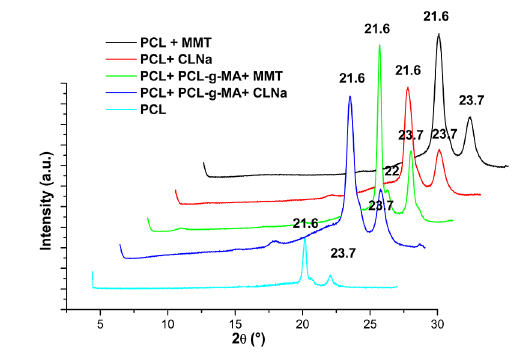
Figure 3. X-ray diffractograms of PCL compounds.